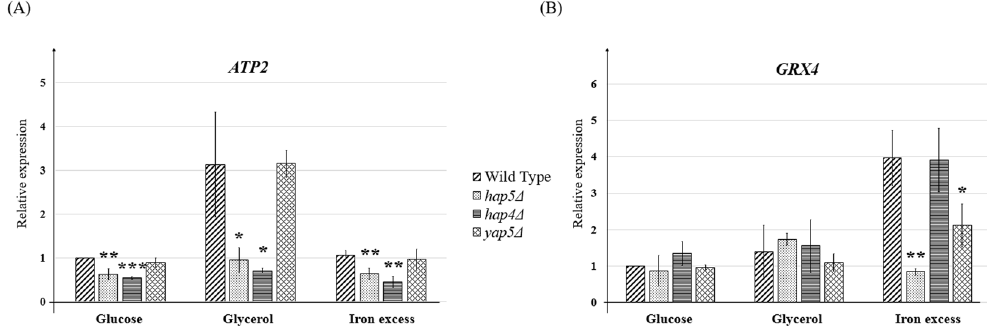
Figure 3. Analyses of the impact of Hap5, Hap4 and Yap5 on ATP2 and GRX4 . The relative expression of ATP2 ( A ) and GRX4 ( B ) was measured by Q-RTPCR in wild type, hap5 Δ , hap4 Δ and yap5 Δ strains grown in glucose, glycerol or iron excess. The values represent the expression levels of the ATP2 or GRX4 genes relative to ACT1 (used as an internal control) and to the wild type grown in glucose. The experiments were performed three times on biologically independent samples. Error bars represent the pearson standard deviation. A t-test was performed to compare, for each growth condition, the mutants to the corresponding wild type. The results of the test are indicated by the stars as follows * p < 0.05, ** p < 0.01, *** p <